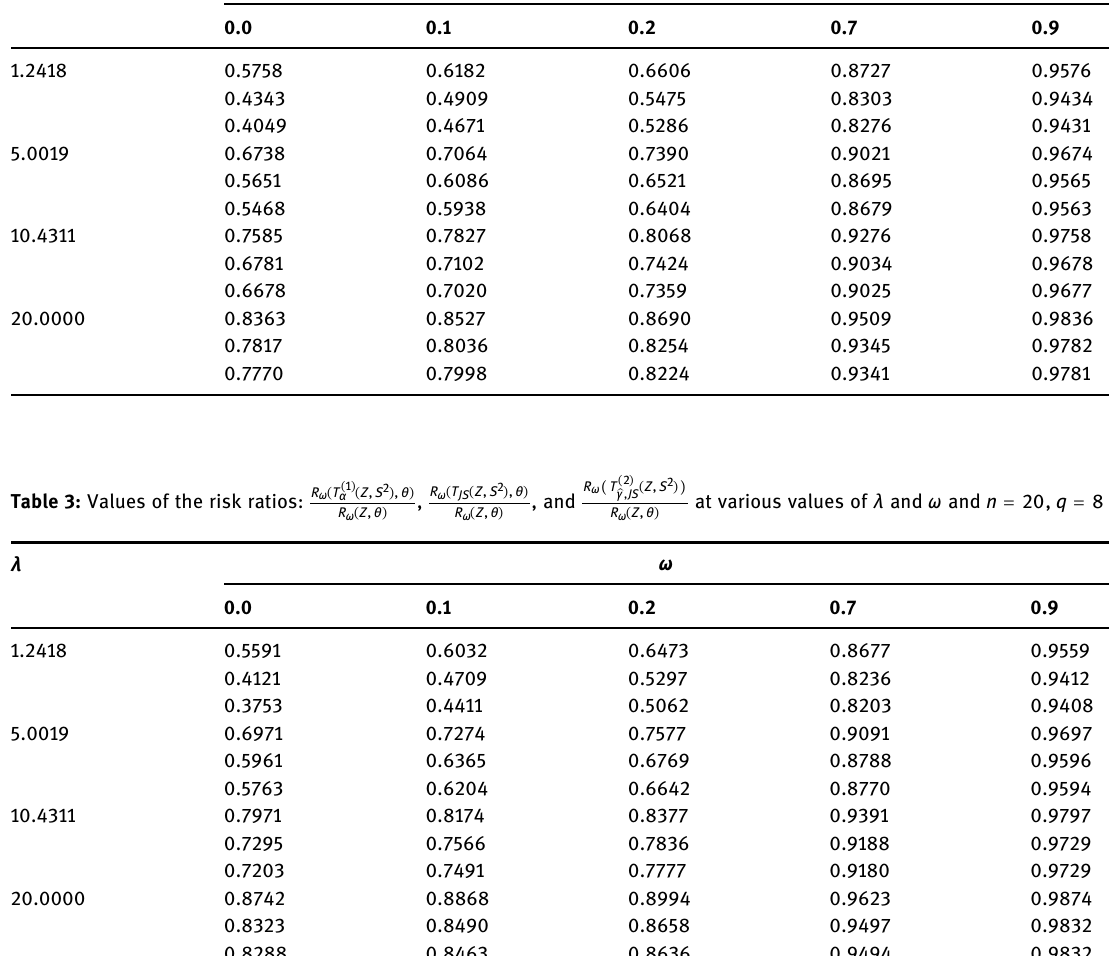
Table 2: Values of the risk ratios: R T Z S θ